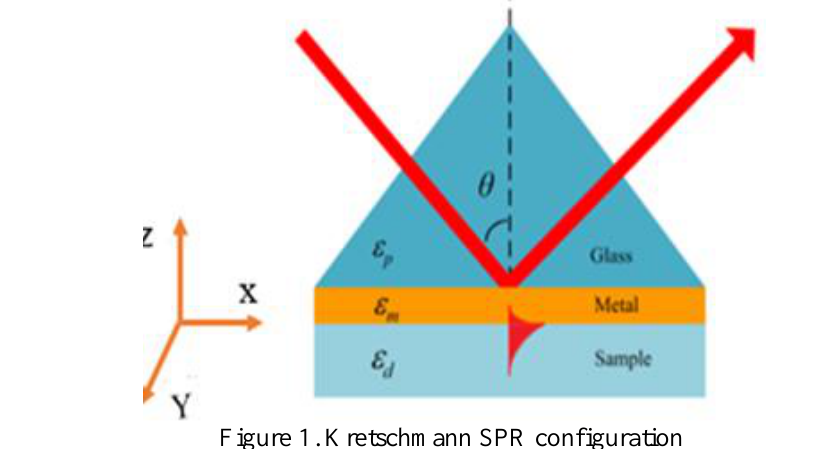
Figure 1. Kretschmann SPR